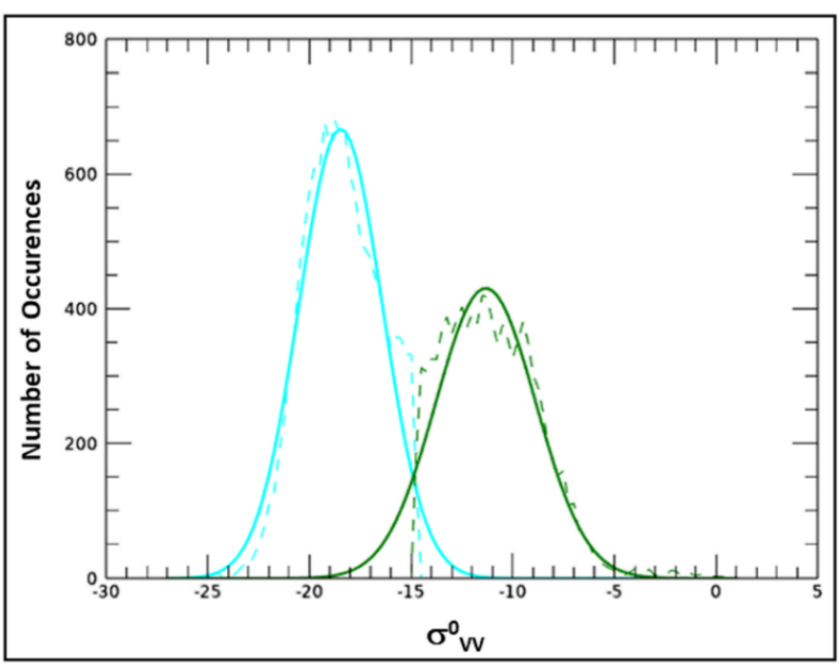
Figure 9. Histogram of the σ 0 values of the subpopulations composed of the pixels belonging to the buffer zone included in the MCDWA (cyan dashed lines) and the buffer zone included neither in the MCDWA, nor in the CDWA (green dashed lines). Solid lines represent the Gaussian functions fitting the histograms. The EMSR359 case study is considered.